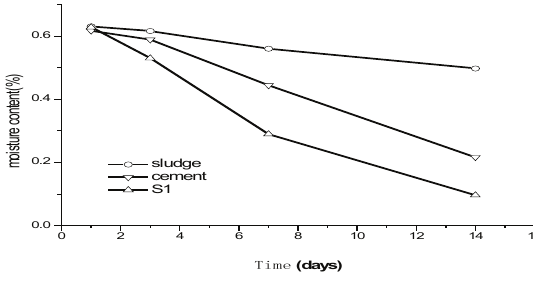
Figure 2: Moisture content change of modified